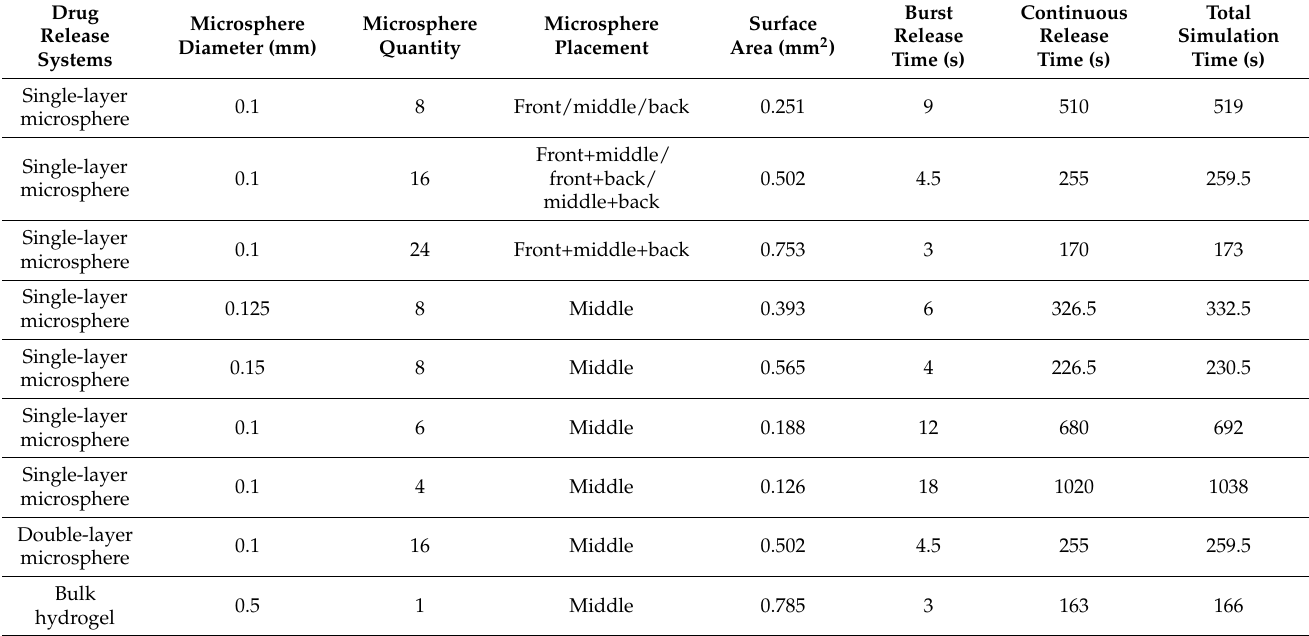
Table 2. Simulation time of the various drug release